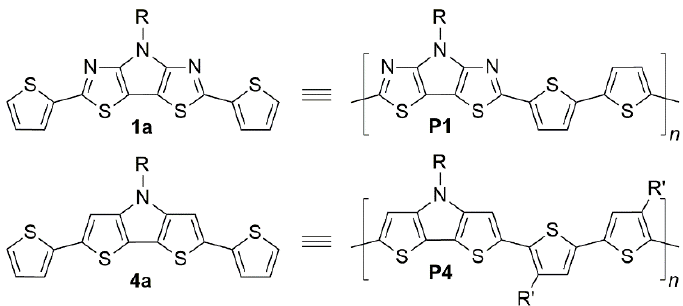
Figure 4. Oligomers 1a and 4a as models of known copolymeric materials.